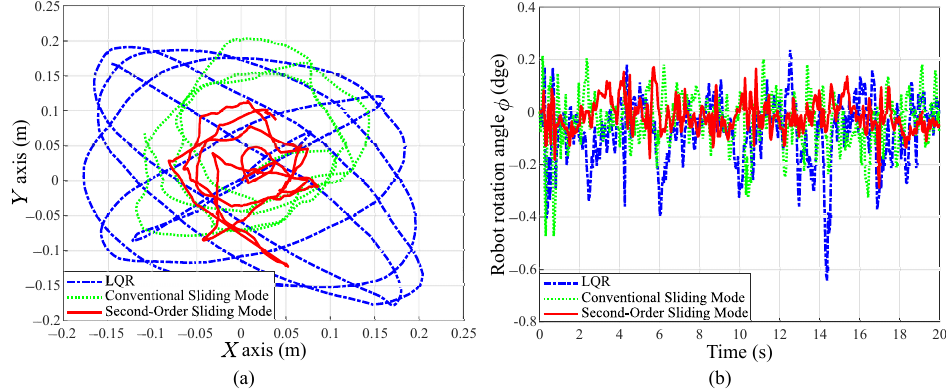
Figure 22. The experimental results compare ( a ) the robot’s trajectory in the X - Y plane and ( b ) the rotation angle responses of the